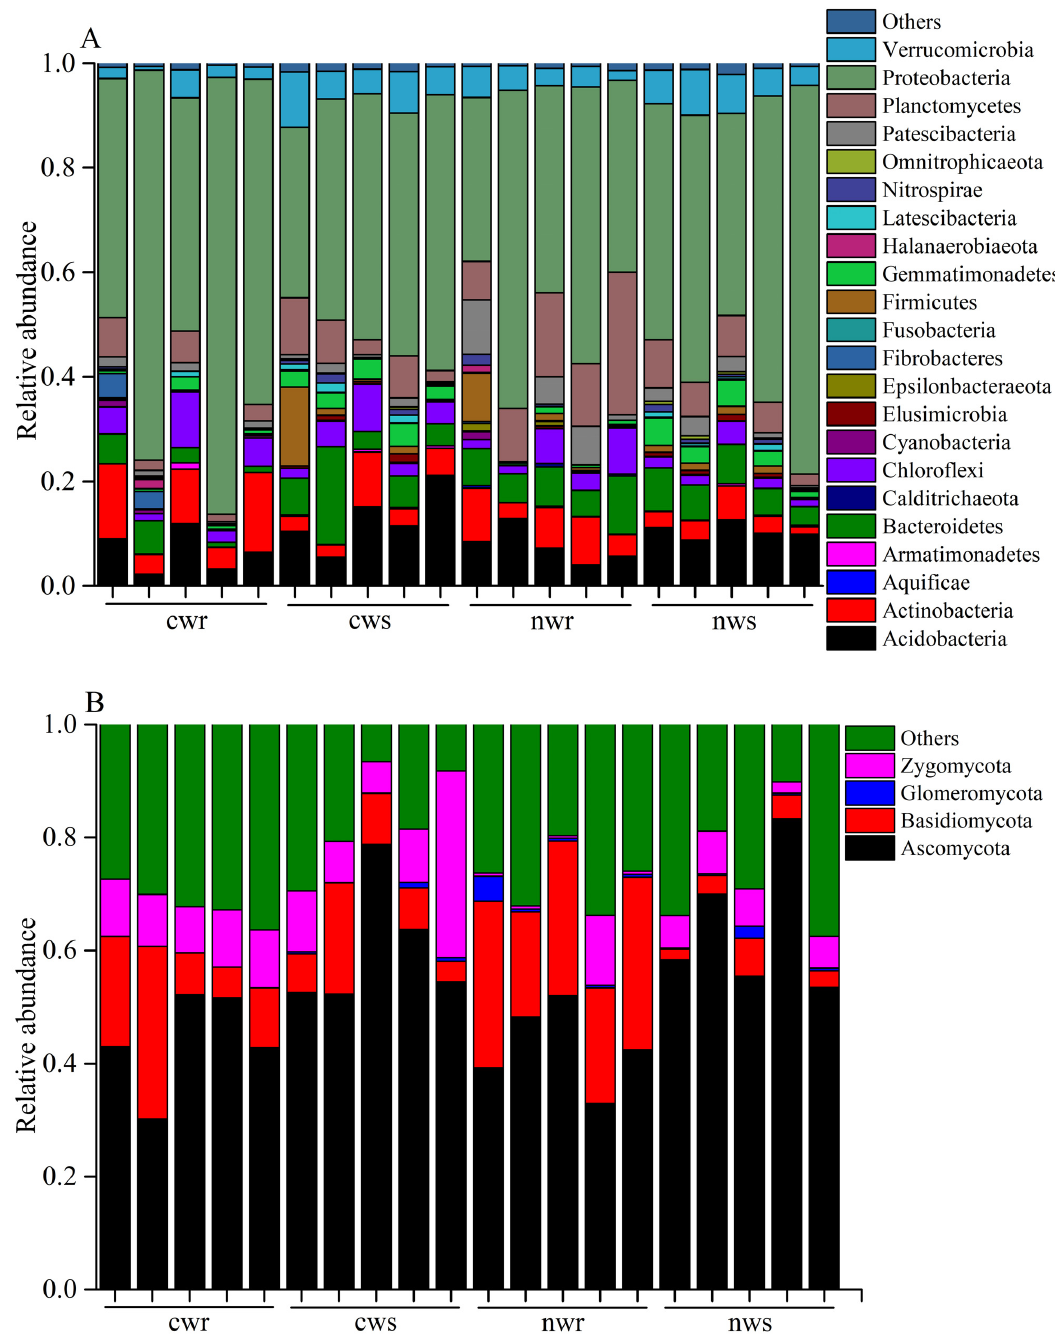
Figure 5. Relative abundance of ( A ) bacteria and ( B ) fungi at the phylum level in the rhizosphere and root endosphere of naturally grown and cultivated walnut trees. cwr—cultivated tree endosphere; cws—cultivated tree rhizosphere; nwr—naturally grown tree endosphere; nws—naturally grown tree rhizosphere.